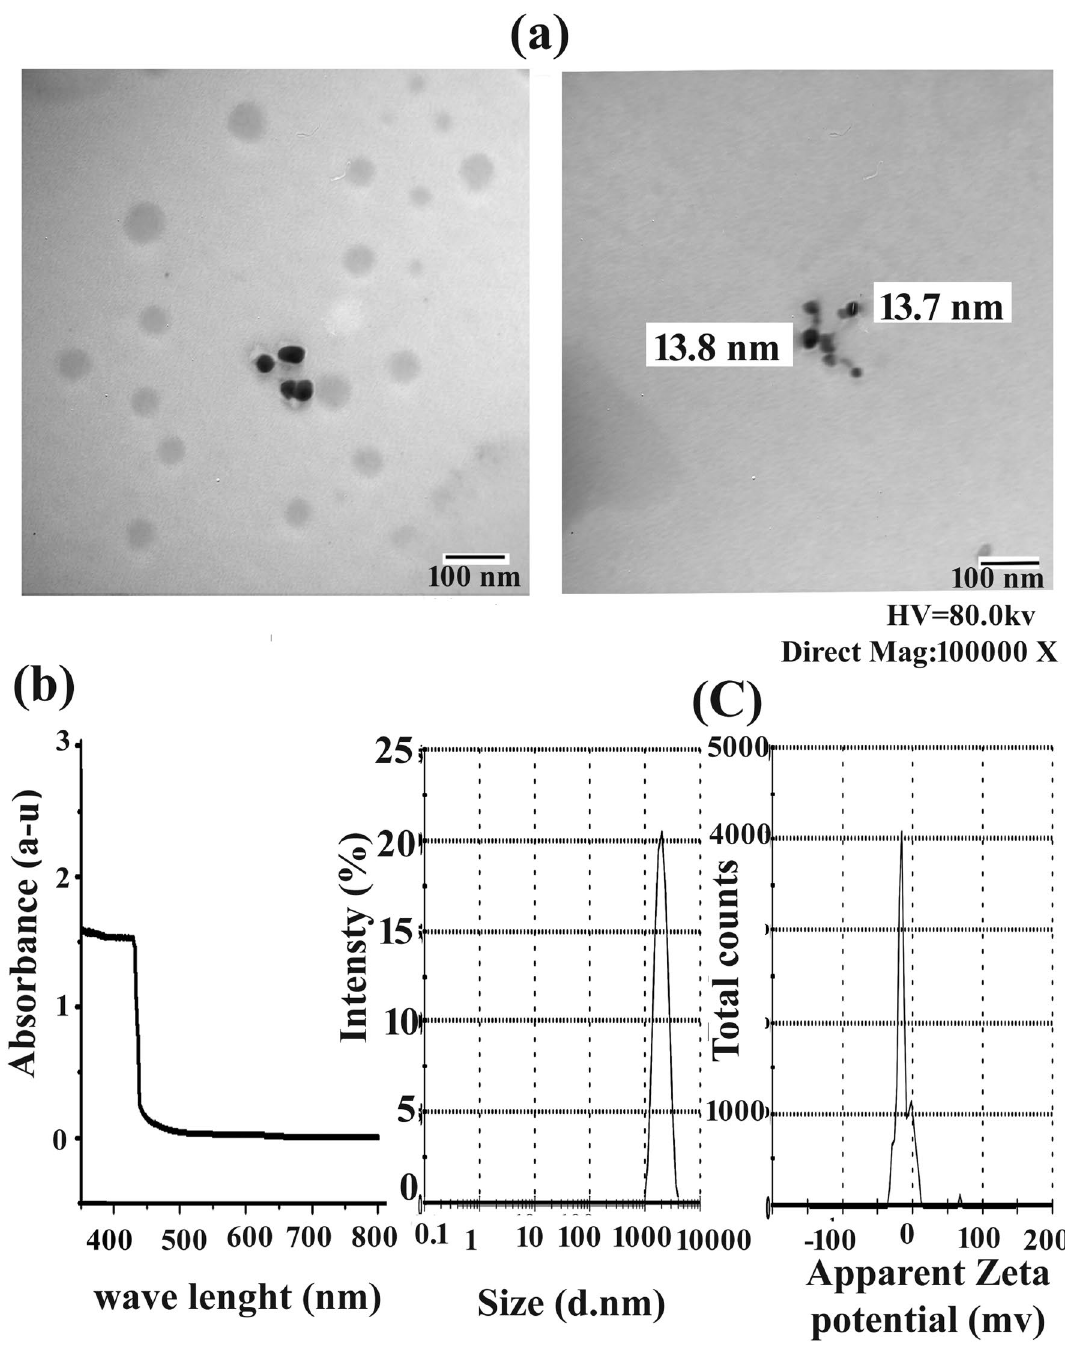
Figure 1. Morphology and physicochemical properties of curcumin nanoparticles. (a) TEM examination of nanocurcumin (N.Cur) (bar = 100 nm). (b) Optical absorption properties. (c) Measurements of zeta potential and mean particle (Fig. 9a), while AC treatment induced marked collagen fiber accumulation among hepatocytes and surround- ing dilated and congested blood sinusoids (Fig. 9b). Cur. pretreatment reduced the number of collagen fibers surrounding hepatocytes, the central vein, and blood sinusoids (Fig. 9c) while N.Cur. appear to reduce collagen fiber density even further (Fig. 9d). Morphometric analysis of collagen deposition confirmed these qualitative observations, with AC increasing deposition by 126.9% compared to control mice (Fig. 9e) and both Cur. and N.Cur. reducing deposition by 42.9% and 55.0%, respectively, compared to the AC group. The rich distribution of red-stained glycogen particles in control liver (Fig. 10a) was markedly reduced in AC-treated liver (Fig. 10b), while both Cur. and N.Cur. treatment restored these glycogen stores (Fig. 10c and d).